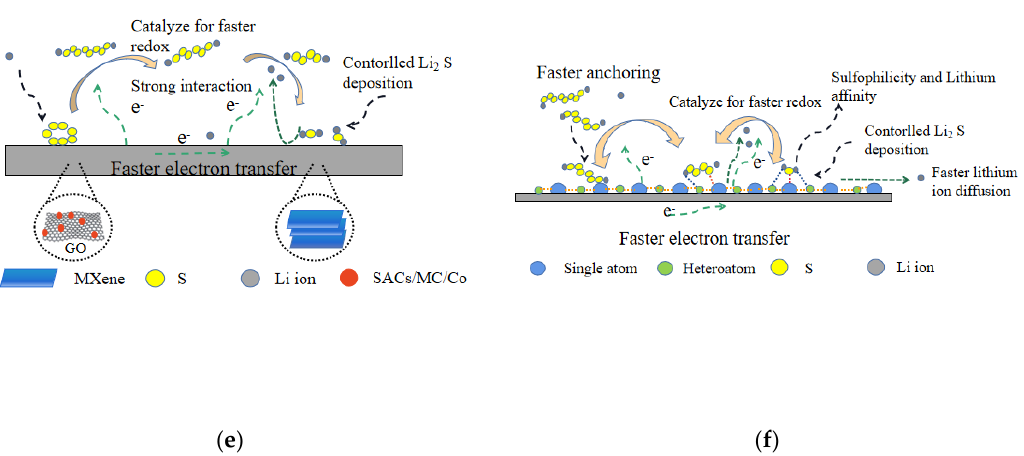
Figure 1. ( a ) The structure of lithium–sulfur battery. ( b ) Schematic diagram of lithium–sulfur battery challenges. ( c ) The first-generation catalyst materials. ( d ) The second-generation catalyst materials. ( e )